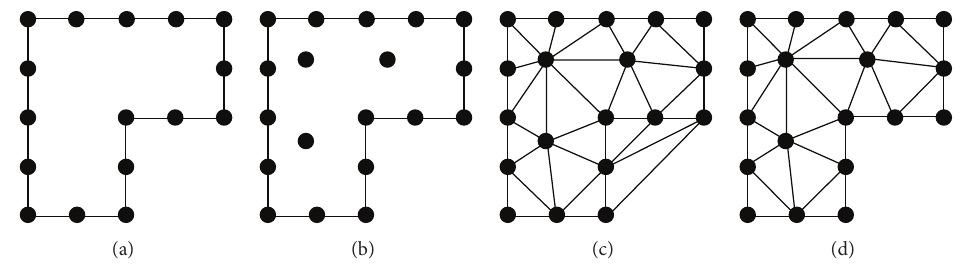
Figure 3: Steps performed by the Delaunay